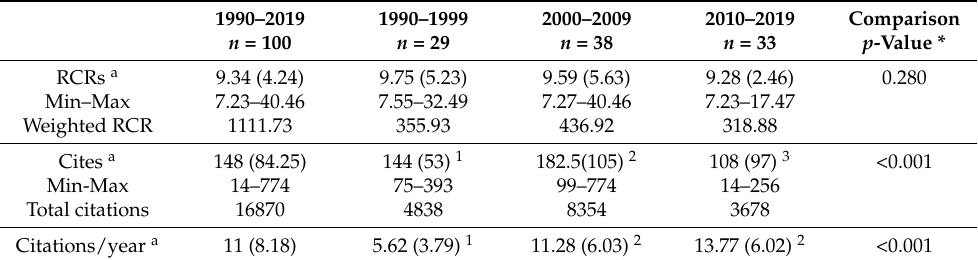
Table 2. Metrics of the top 100 most influential root canal disinfection articles, with the highest relative citation rates (RCRs): 1990–2019.